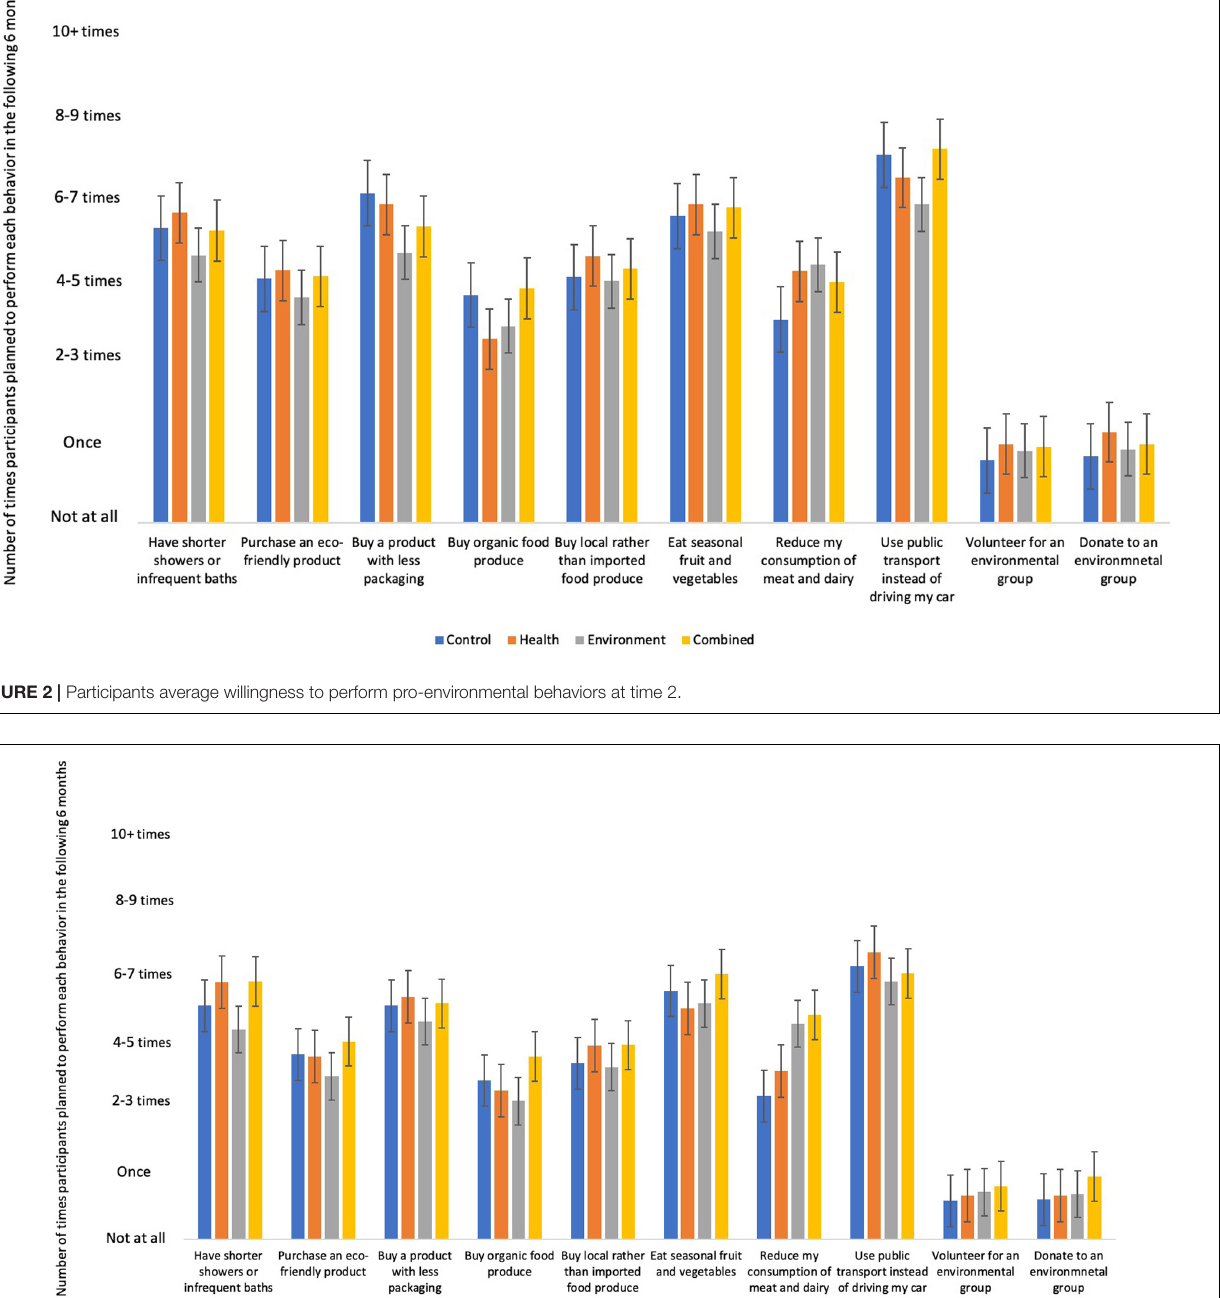
dummy coded environment, health and combined conditions, with the control condition as the reference group, as independent variables. Willingness to perform each of the